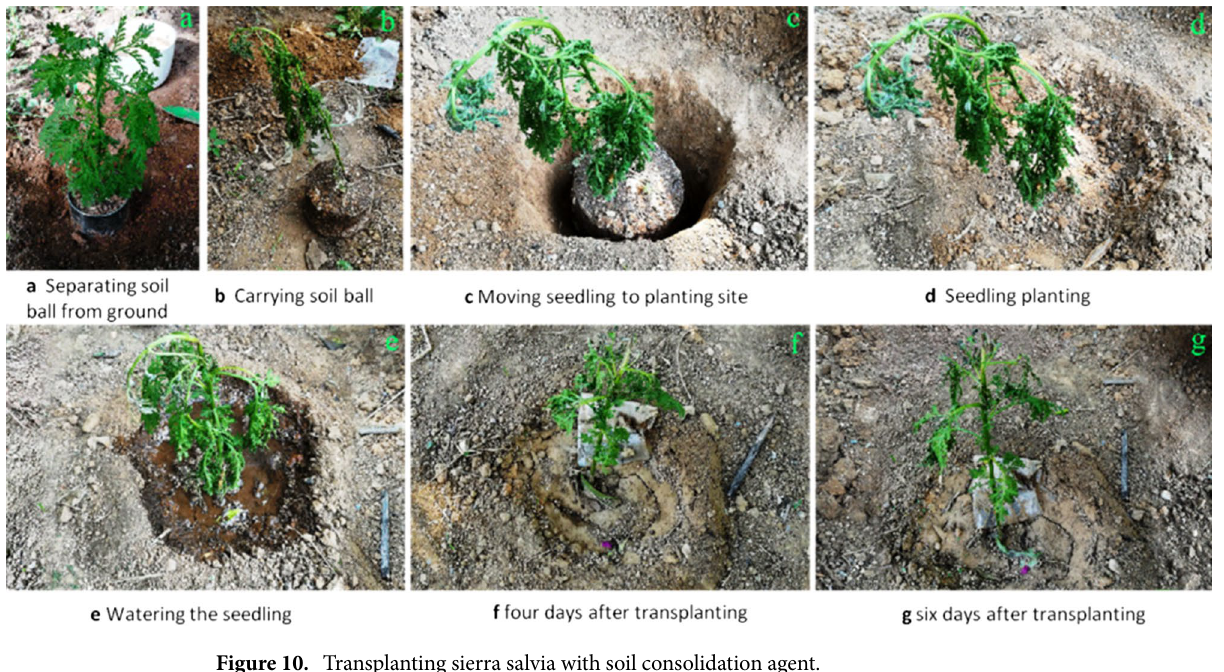
Figure 10. Transplanting sierra salvia with soil consolidation agent.